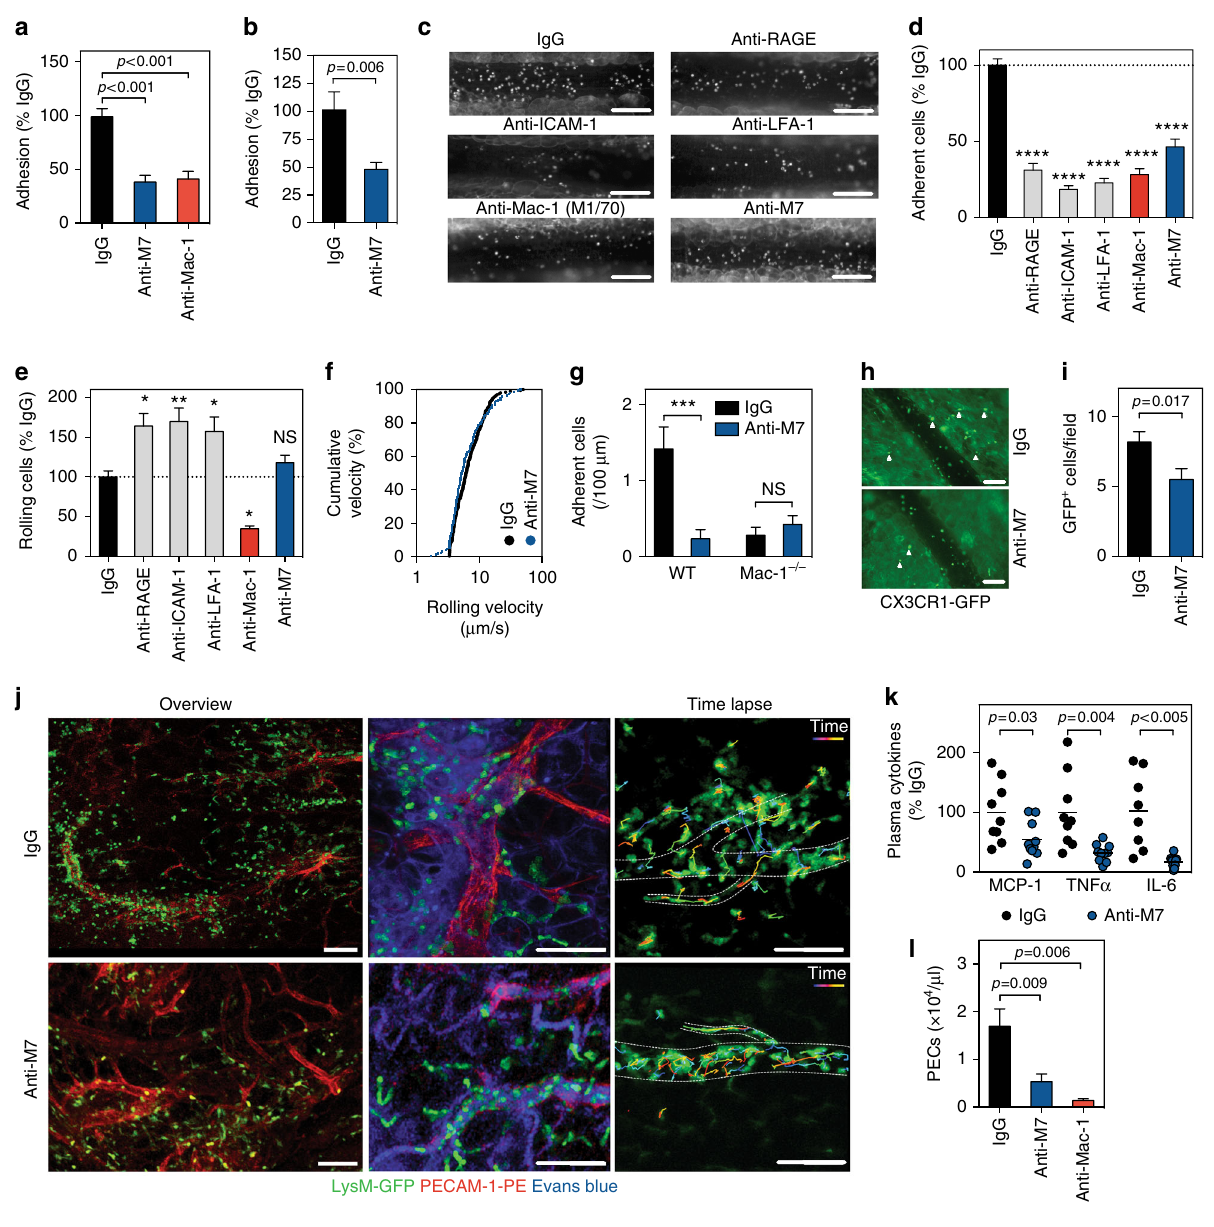
Fig. 2 Treatment with anti-M7 prevents in fl ammatory leukocyte recruitment in vitro and in vivo. a Murine peritoneal macrophages were incubated on dishes coated with mouse CD40L in the presence of 10 μ g/ml of IgG, anti-M7, or anti-Mac-1 (clone M1/70). Adhering cells were normalized to % of the IgG-treatment. b Murine RAW-cell adhesion on TNF α -primed murine endothelial cells under physiological fl ow in the presence of IgG or anti-M7 antibodies (10 μ g/ml). c – f C57Bl/6 mice were injected i.p. with 200 ng TNF α and 15 min before microscopy with F ab fragments of an IgG control antibody, or antibodies against RAGE, ICAM-1, LFA-1, Mac-1 (clone M1/70), or anti-M7 (100 μ g i.p.). Leukocyte recruitment was monitored by intravital microscopy 4 h later: Adhering ( d ) and rolling leukocytes ( e ) were quanti fi ed as % of IgG. ( f ) Cumulative frequency of leukocyte rolling velocity. g Leukocyte adhesion in intravital microscopy in IgG or anti-M7 treated WT and Mac-1 − / − mice. h , i Number of CX3CR1-GFP + monocytes (white arrows) in the para-vascular space 4 h after treatment with IgG or anti-M7 and 200ng TNF α . j Confocal in vivo imaging of the greater omentum after local stimulation with TNF α and i.v. injection of the indicated antibodies (100 μ g) in LysM-GFP reporter mice. LysM-GFP + myeloid cells were tracked over time. Time lapse and cell tracking is shown over 15 min (right panel). k Plasma cytokine levels of mice subjected to intravital microscopy after IgG or anti-M7 F ab treatment. l Peritoneal exudate cells (PECs) 72 h after induction of a sterile peritonitis and the indicated antibody treatment. Scale bars represent 100 μ m ( c , h , j ). Error bars indicate mean ± SEM. Statistical signi fi cance was assessed by a two-sided, unpaired Student ’ s T -test between the indicated groups ( a , b , g , i , k , l ) or in comparison to IgG-treatment ( d , e ). * P < 0.05, ** P < 0.01, *** P < 0.001, **** P < 0.0001. N ≥ 3 independent experiments ( a , b ). N ≥ 10 mice per group ( d , e , f , g ), N ≥ 6 mice per group ( l , h